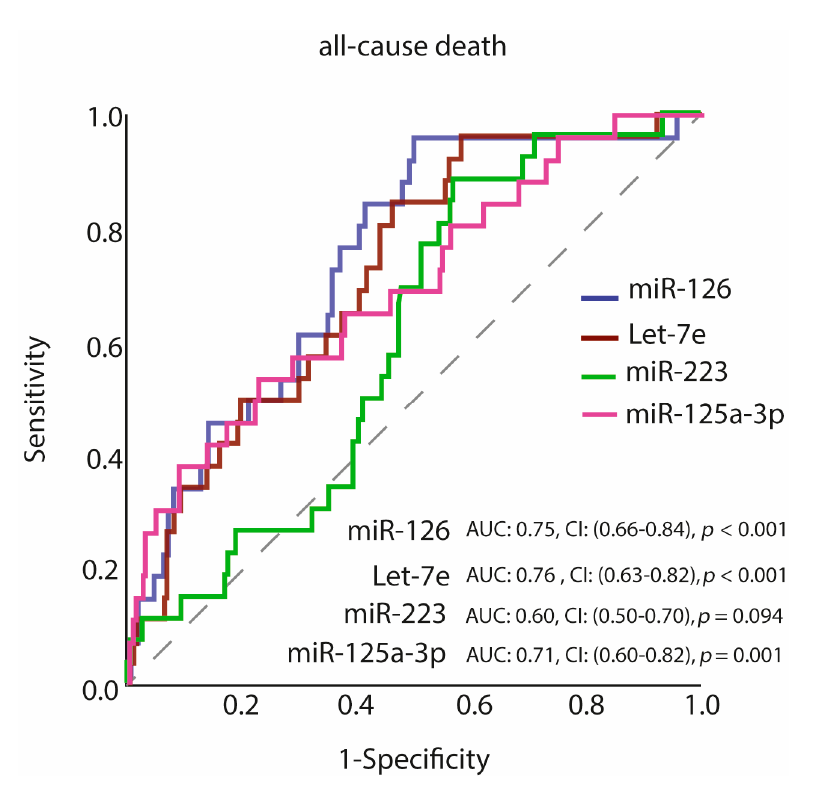
Figure 2. Receiver operating characteristic (ROC) curves of miR-126, Let-7e, miR-223, miR-125a-3p for prediction of all-cause death. Abbreviations: AUC, area under the curve; CI, 95% confidence interval.